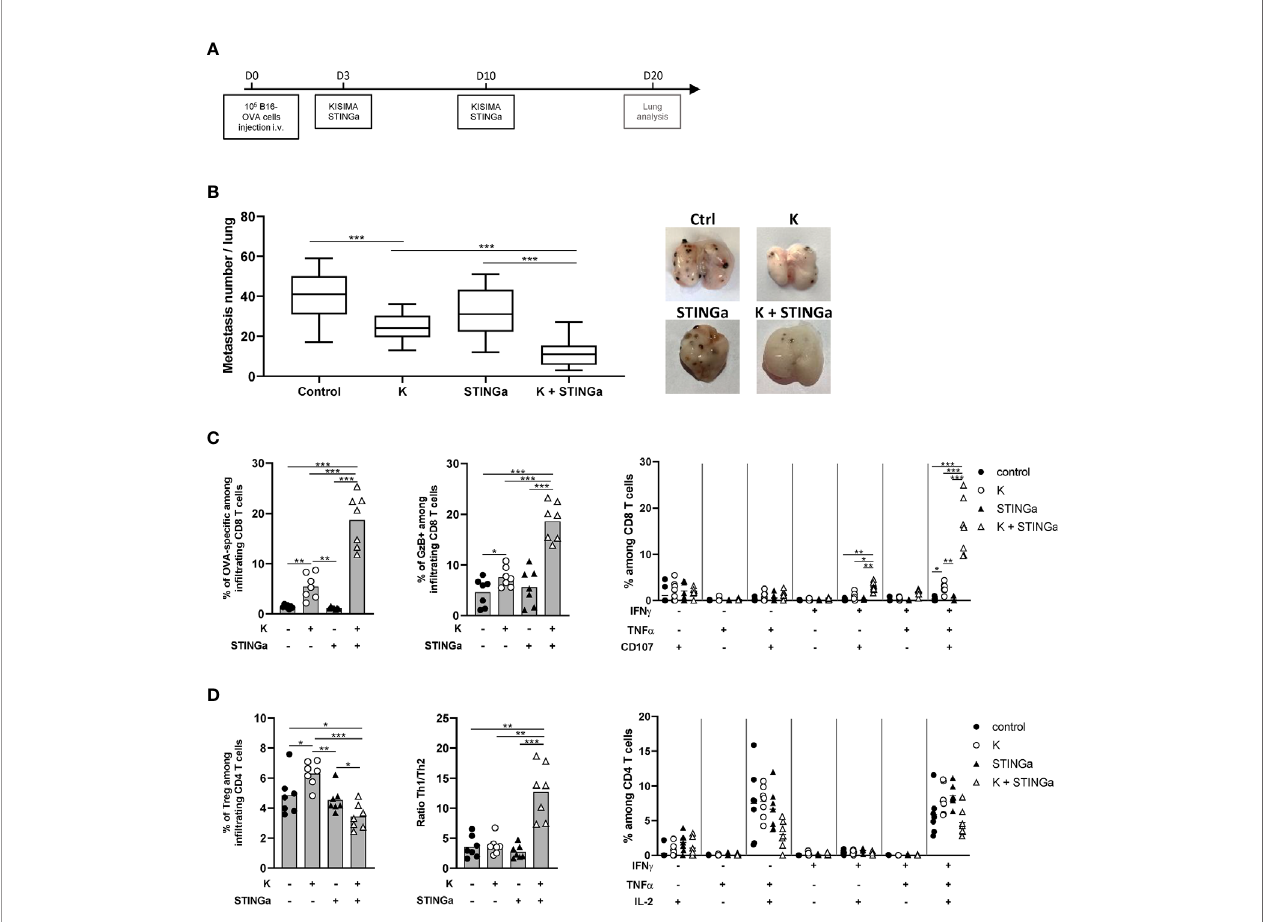
FIGURE 2 | Combining protein vaccine with STING agonist inhibits B16-OVA tumor growth. 10 5 B16-OVA cells were injected intravenously into C57BL/6 mice. At days 3 and 10 post tumor injection, mice were treated with two administrations of KISIMA vaccine, STING agonist or a combination of the two. At day 20, the number of lung metastasis was counted, and lung in fi ltrating lymphocytes were analyzed. (A) Vaccination schedule. (B) Number of metastatic nodules per lung and representative pictures. (C) Frequency of SIINFEKL (OVA)-speci fi c CD8 T cells among tumor in fi ltrating leukocytes and expression of Granzyme B was measured by fl ow cytometry. Antigen-speci fi c cytokine production by CD8 T cells was measured by intracellular staining after e x vivo stimulation with SIINFEKL peptide in presence of Golgi inhibitor. Antigen-speci fi c cytokine production was measured by intracellular staining; frequency of cytokine-producing among CD8 T cells is shown. (D) Frequency of Treg (FoxP3 + ) and Th1/Th2 ratio was measured by fl ow cytometry. Antigen-speci fi c cytokine production by CD4 T cells was measured by intracellular staining after e x vivo stimulation with ISQAVHAAHAEINEAGR (OVA-CD4) peptide in the presence of Golgi inhibitor. Antigen-speci fi c cytokine production was measured by intracellular staining; frequency of cytokine-producing among CD4 T cells is shown. (B – D) One representative of two experiments is shown (n = 7/group/replicate), Mann – Whitney test , *p < 0.05, **p < 0.01, ***p <